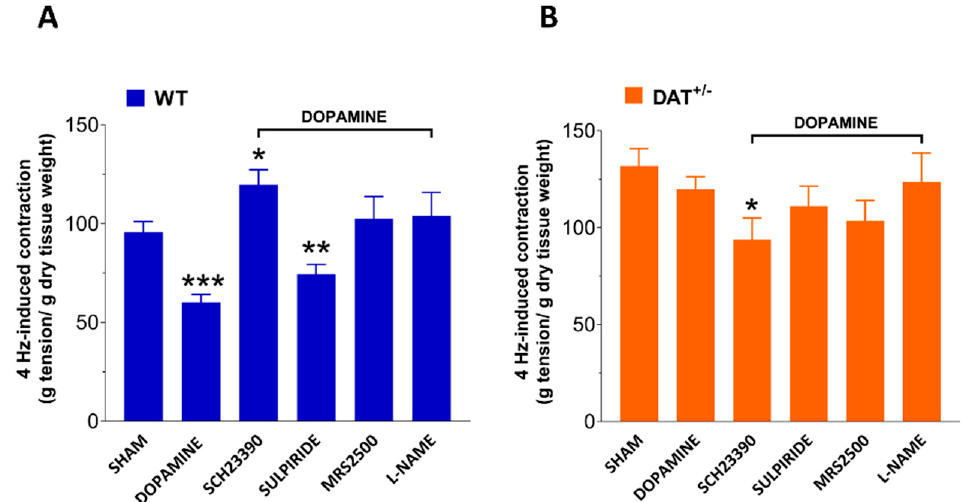
Figure 2. DAT hypofunction affects dopaminergic neuromuscular response. Neuromuscular excita- tory response induced by 4 Hz-EFS in absence or presence of 10 µ M dopamine after pretreatment with SCH23390, sulpiride, MRS2500 or L-NAME in isolated ileal preparations of WT ( A ) and DAT +/ − ( B ) mice. Data are reported as mean ± SEM. * p < 0.05, ** p < 0.01, *** p < 0.001 vs. respective control mice. n = 5 mice/group.